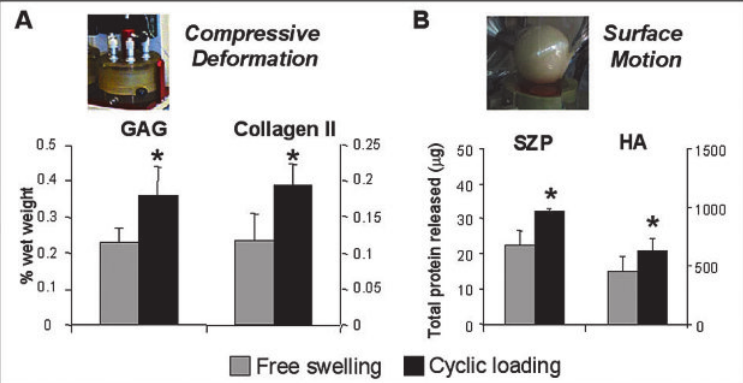
Responsiveness of nasal chondrocytes to mechanical loading. Synthesis of glycosaminoglycans (GAG) and type II collagen (Collagen II) increases in response to compressive mechanical loading on grafts generated from expanded nasal chon- drocytes (A). Additionally, the expression of the lubricating factors superficial zone protein (SZP) and hyaluronan (HA) is induced in response to surface motion (B). Asterisks indicate statistically significant differences from the static (free swelling) controls